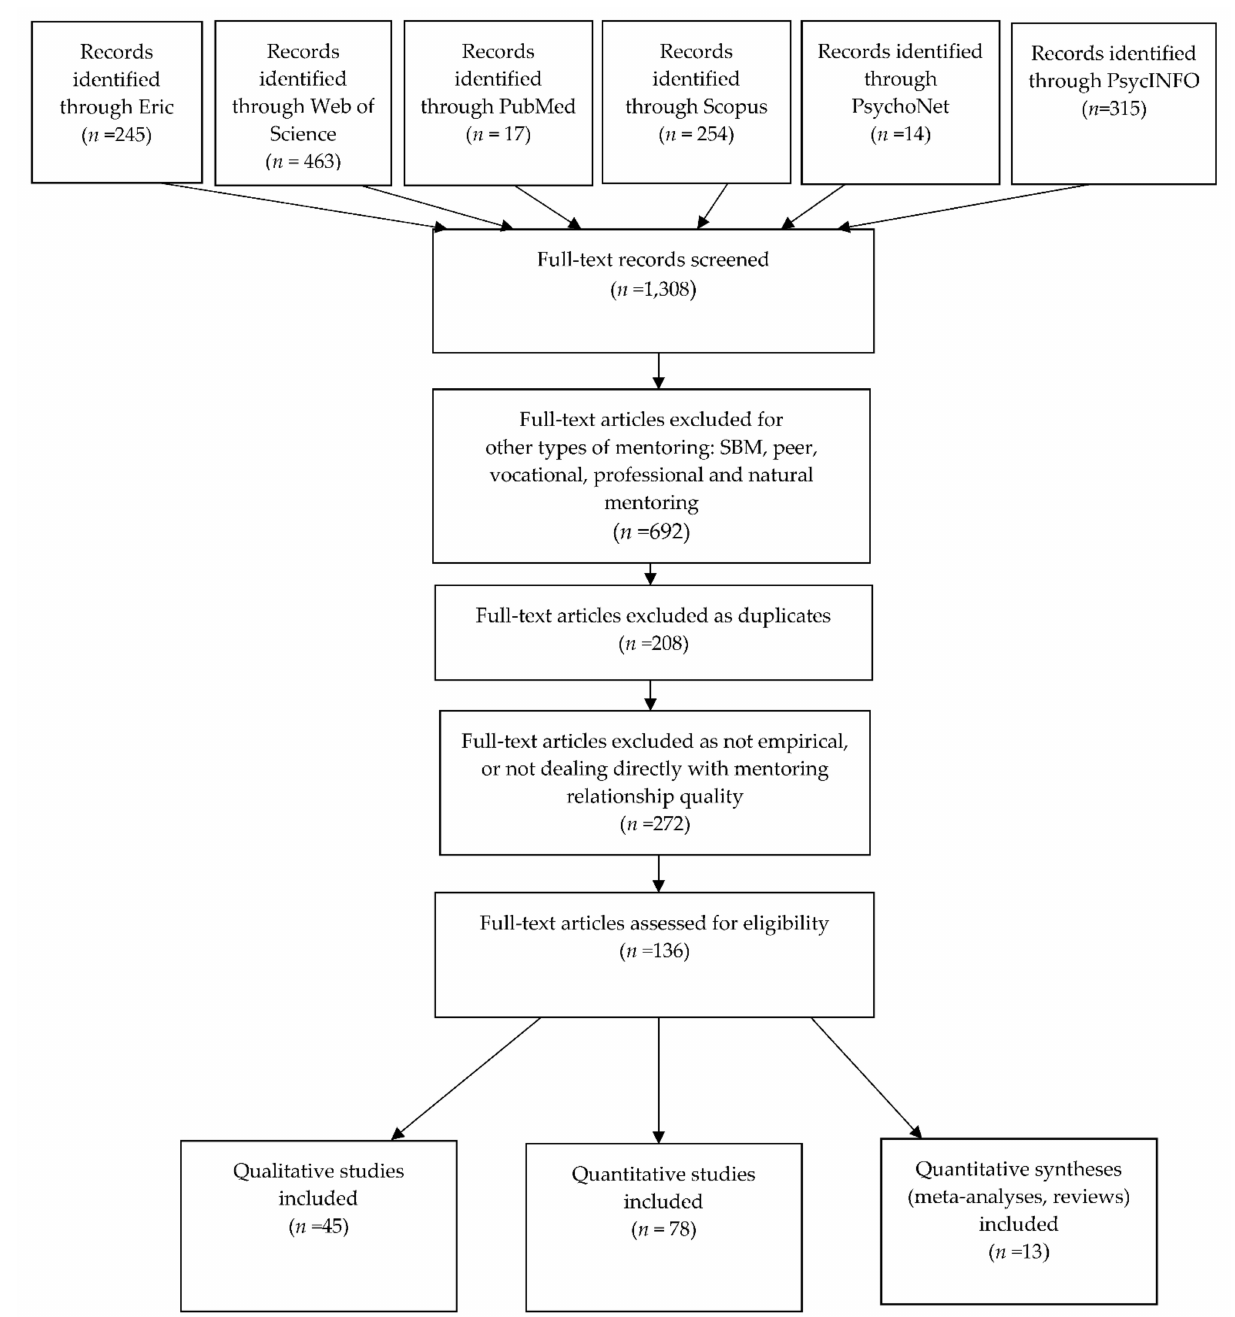
Figure 1. Flow chart of the methodology applied to screen